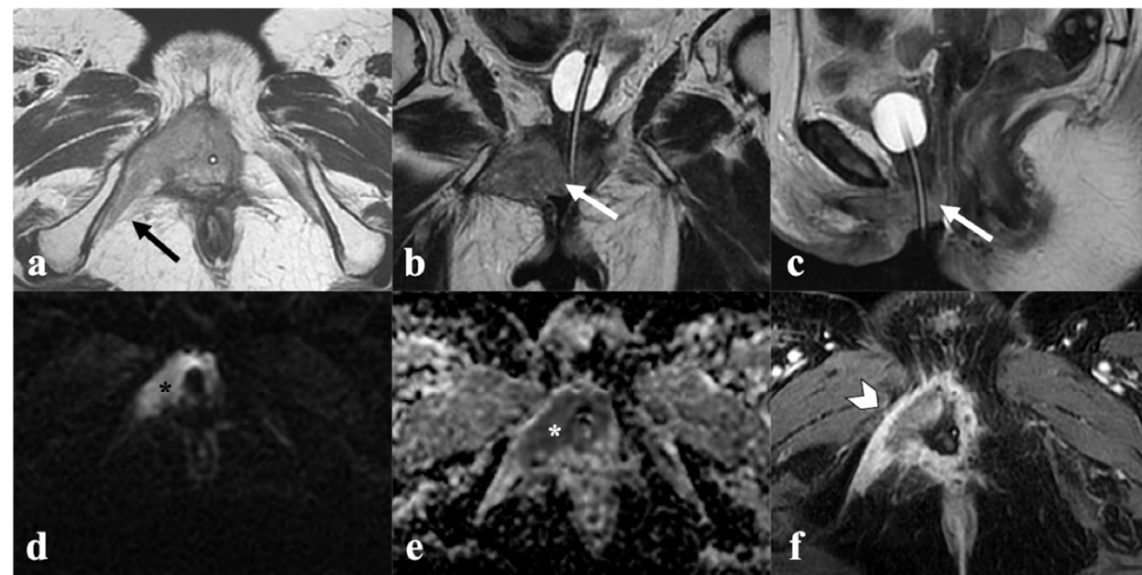
Figure 5. Skin bridge recurrence. A 68-year-old patient previously treated with radical vulvectomy, lymphadenectomy, and RT for locally advanced vulvar carcinoma, presenting 5 years later with a voluminous mass of intermediate T2 signal intensity infiltrating, laterally, the right internal obturator muscle (( a )—black arrow), cranially, the lower third of the vagina (( b )—white arrow), and anteriorly, the urethra (( c )—white arrow). The solid tissue shows diffusion restriction in both DWI (( d )—black asterisk) and ADC map (( e )—white asterisk) and marked enhancement in post-contrast T1-WI (( f )—white arrowhead), consistent with recurrence. Once more, initial lymph node involvement constitutes a risk factor [37].